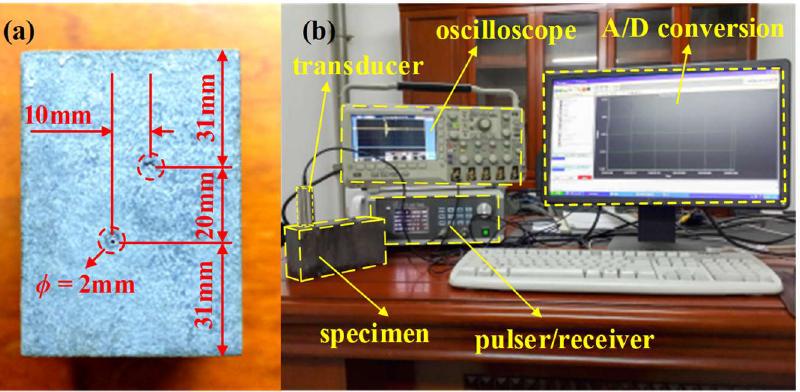
Figure 7. ( a ) A stainless steel specimen with two flaws. ( b ) The setup of the experiment system.